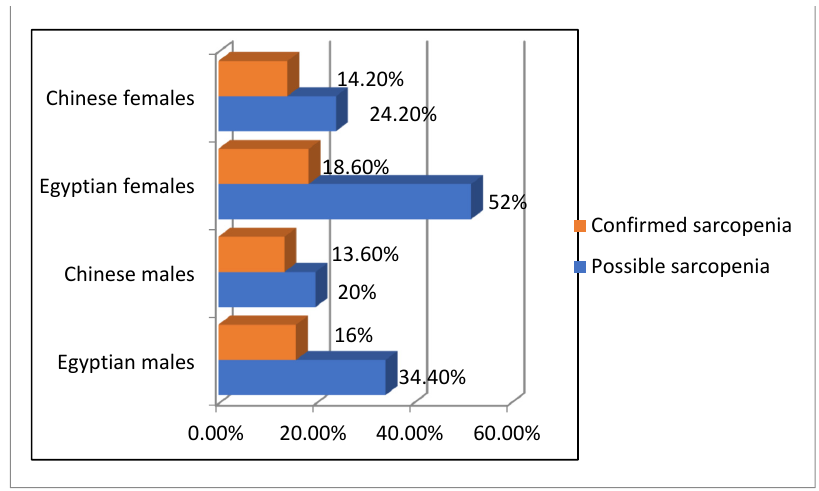
Figure 3. Illustrates the prevalence of possible and confirmed sarcopenia among Egyptian and Chi- nese patients.